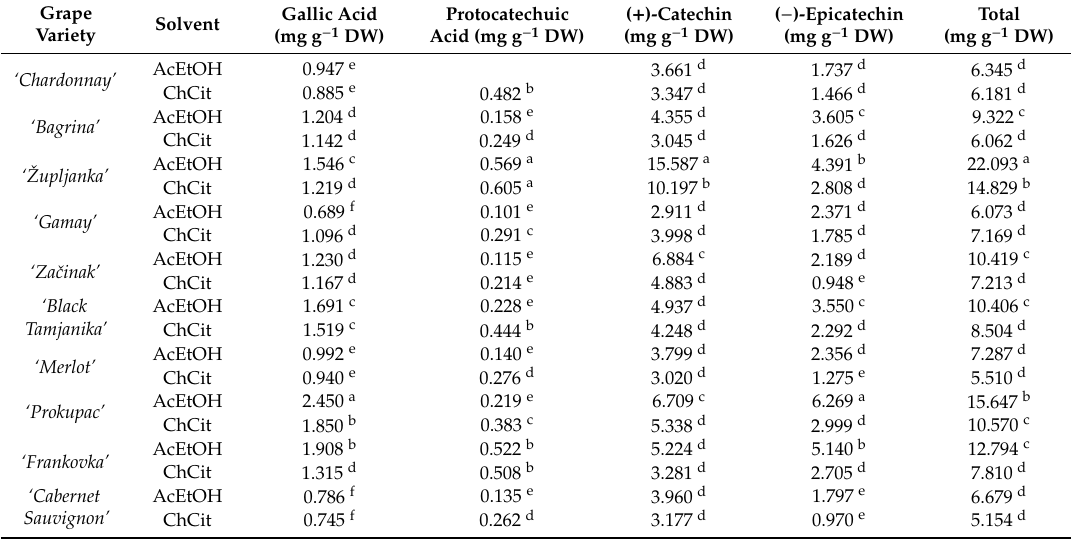
Table 3. Phenolic composition of grape seed extracts.